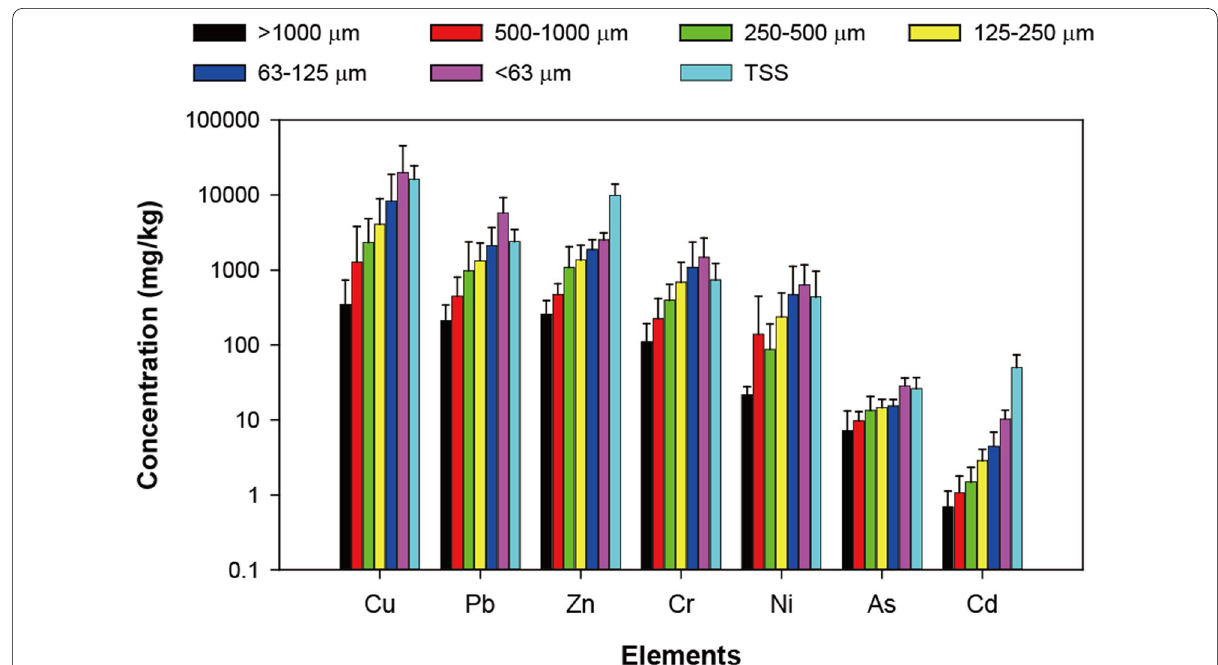
Fig. 2 Comparison of heavy metal concentrations in different sizes of RDS and TSS in this study